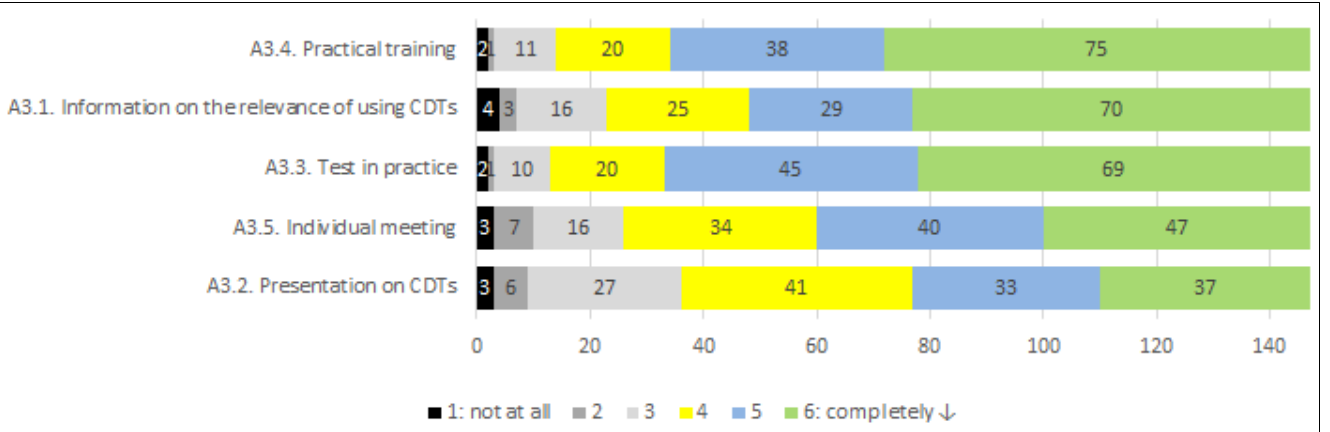
Figure 7. Solutions of enhancing the acceptance of the use of CDTs (A3,